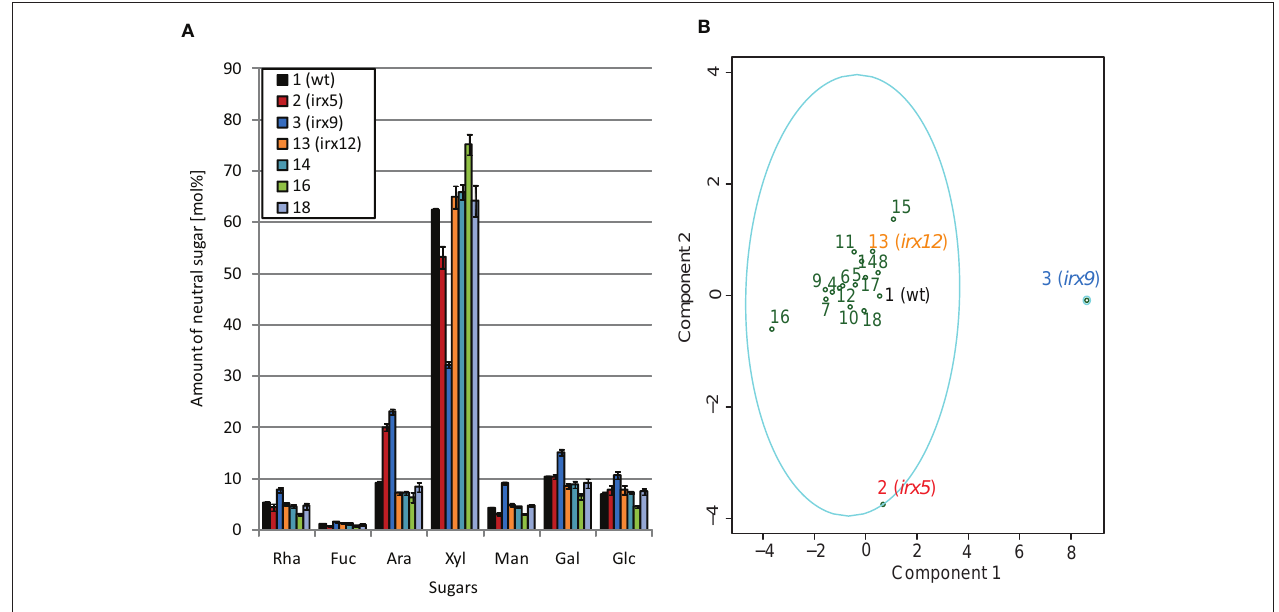
Figure 4 | Principal component analysis and clustering of crude cell wall sugar estimates for the selected mutants. (A) GC–MS analysis of sugar alditols of crude cell wall material for indicated mutants. (B) Principal component analysis (PCA) of the mol% sugar values from the crude cell wall material. The first two components explain 93.12% of the variation. The loadings for the variables are displayed in supplementary Figure S3 in Supplementary Material.